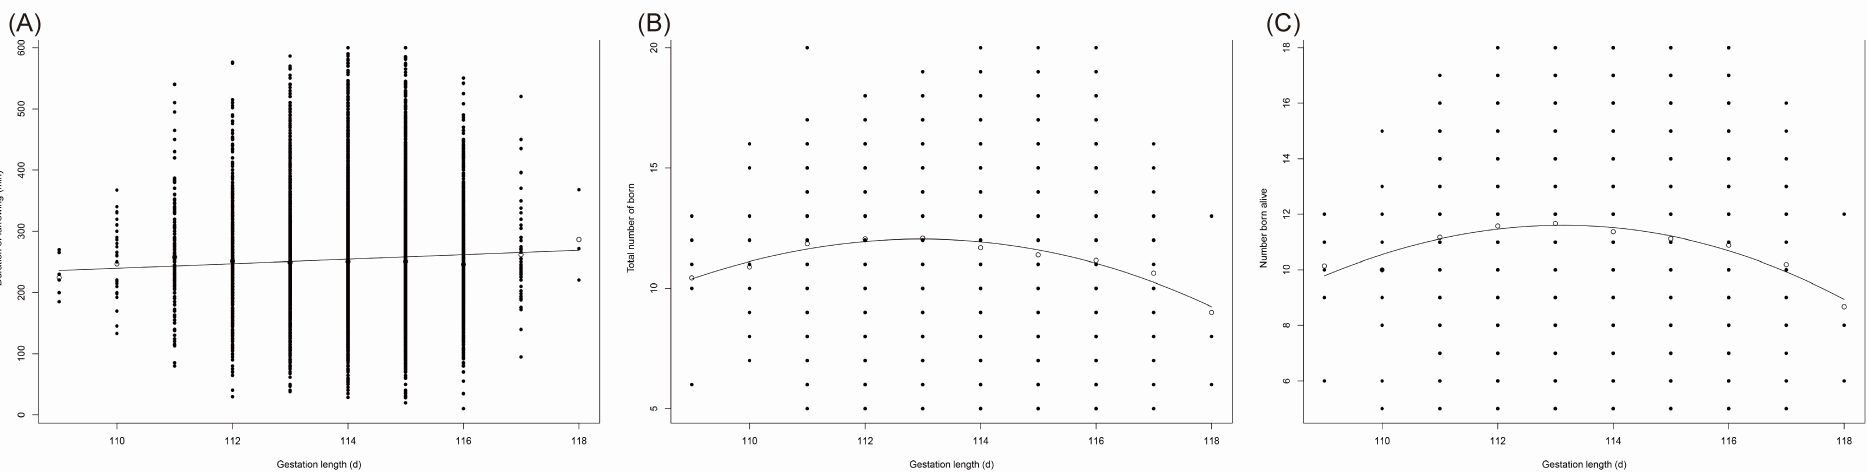
Figure 3. Relation between gestation length and farrowing duration and litter size. Relation between farrowing duration ( A ), total number born ( B ) and number born alive ( C ) with gestation length. Table 7. Descriptive statistics of farrowing duration and litter size of different gestation length.